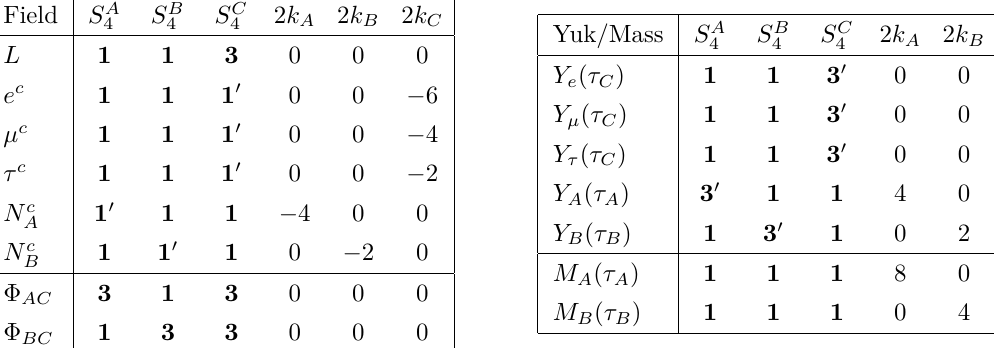
Table 1 . Transformation properties of fields and modular forms (Yuk/Mass) under the modular